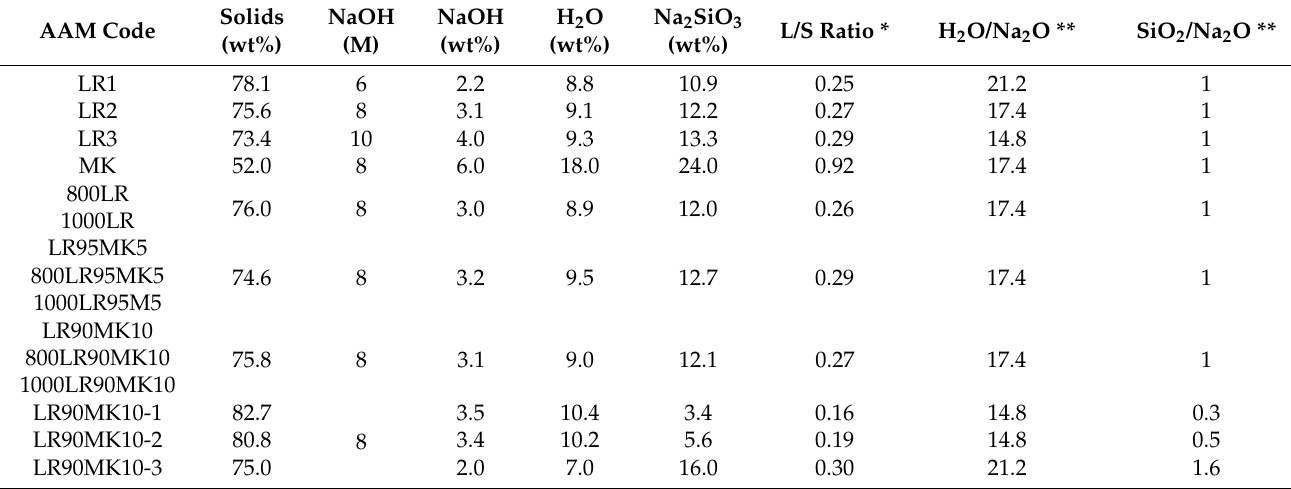
Table 2. Alkali activated material (AAM) codes, raw material used, and selected molar ratios in the activating solution. AAM